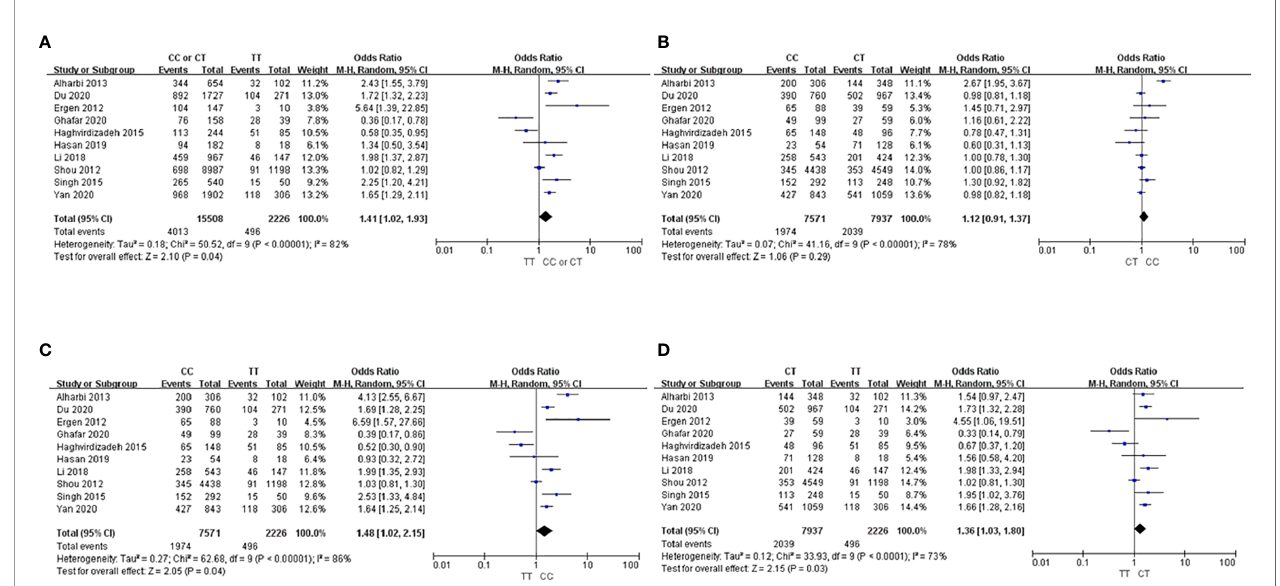
FIGURE 2 | Forest plots showing the association between the ABCA1 69C>T genotype and T2DM risk. (A) CC or CT vs. TT, (B) CC vs. CT, (C) CC vs. TT, (D) CT vs.